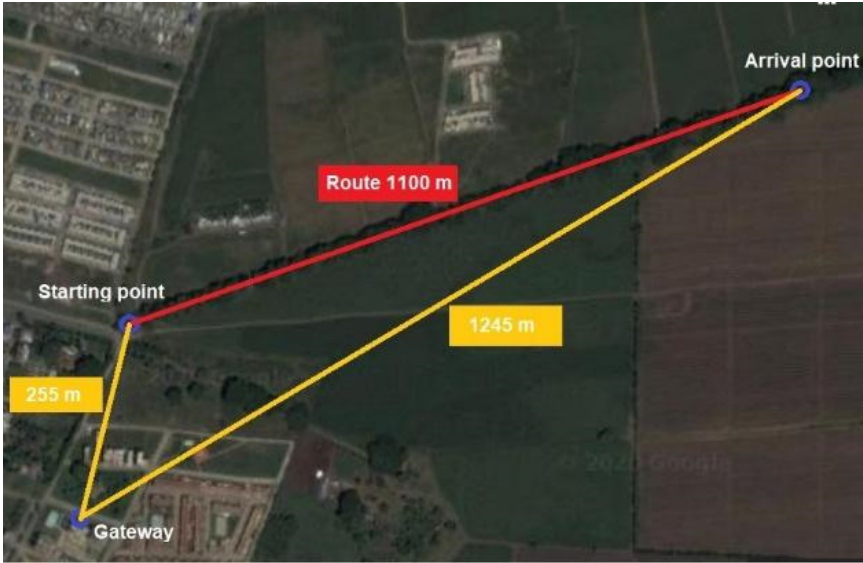
Figure 5. Vehicle route in Experiment 4 and distances to the gateway.